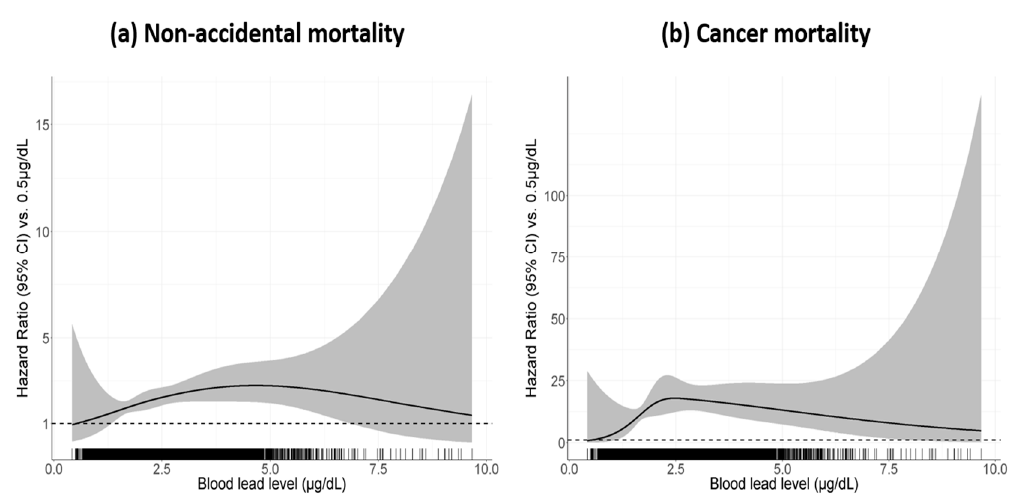
Figure 3. The hazard ratio of ( a ) non-accidental and ( b ) cancer mortality for blood lead levels compared with referent level of 0.5 µ g / dL. The solid lines represent the fitted spline relationship and the shaded areas represent the 95% CI. The tick marks on the x -axis identify the location of the blood lead